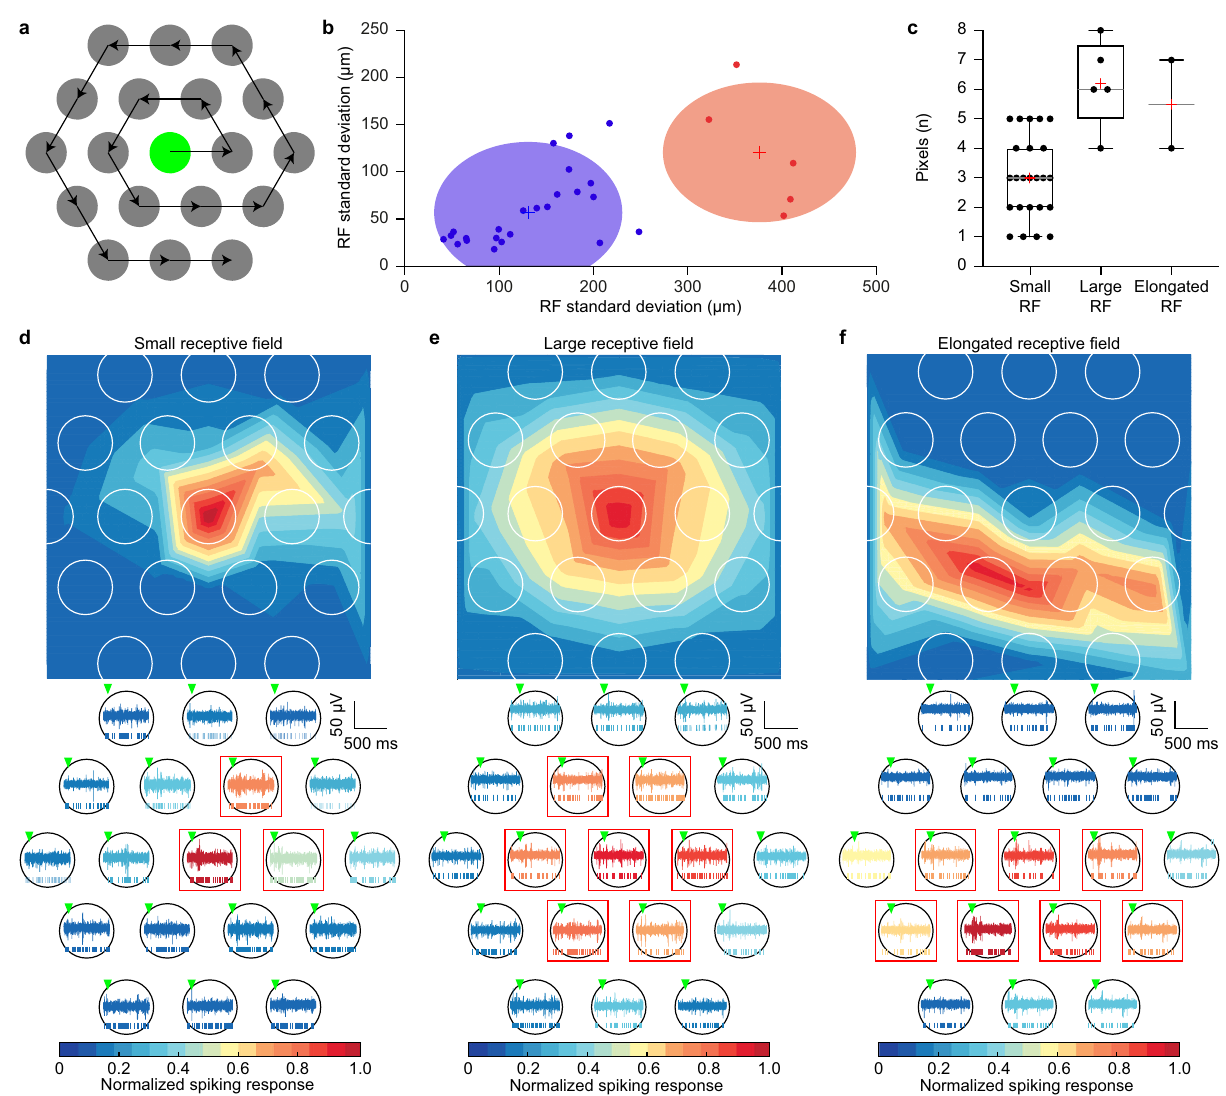
Fig. 5 Photovoltaic epiretinal receptive fi elds. a Sketch of the temporal pattern used for stimulation. Each of the 19 pixels centred around the recording location was successively illuminated following a counterclockwise pattern (560 nm, 10 ms, 0.9 mWmm − 2 ). The total illumination sequence was repeated for ten consecutive sweeps. The photovoltaic RFs were obtained by two-dimensional Gaussian approximation of the network-mediated ML responses elicited by single-pixel, averaged over sweeps, and normalised to the maximal responding pixel. b Gaussian mixture model of the photovoltaic RF sizes over the small ( n = 24 RGCs, blue) and large RGC populations ( n = 5 RGCs, red). The average photovoltaic RF diameter of the small and large cells types are, respectively, of 153.7 ± 26.1 µ m and 335.5 ± 49.3 µ m (mean ± s.e.m.). c Quanti fi cation of the number of pixels able to induce statistically signi fi cant ( P < 0.05) ML activation in the recorded RGC. The horizontal grey line is the median, the red plus is the average and the boxes extend from the 25th to 75th percentiles. d – f Photovoltaic RFs from three individual RGCs classi fi ed as small RF cell ( d ), large RF cell ( e ) and elongated RF cell ( f ). The bottom panels show raw electrophysiological recordings and raster plots from the same cells for each single-pixel illumination (560 nm, 10 ms, 0.9 mW mm − 2 , fi rst sweep). The red boxes show the pixels inducing a statistically signi fi cant activation of the recorded